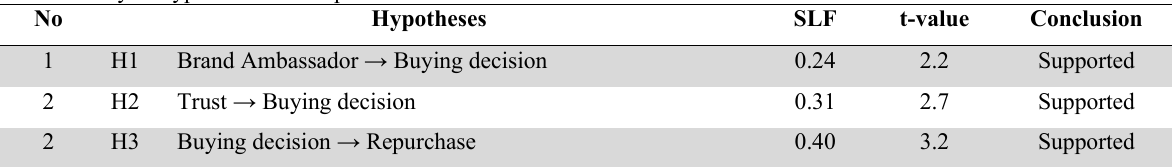
The summary of hypotheses